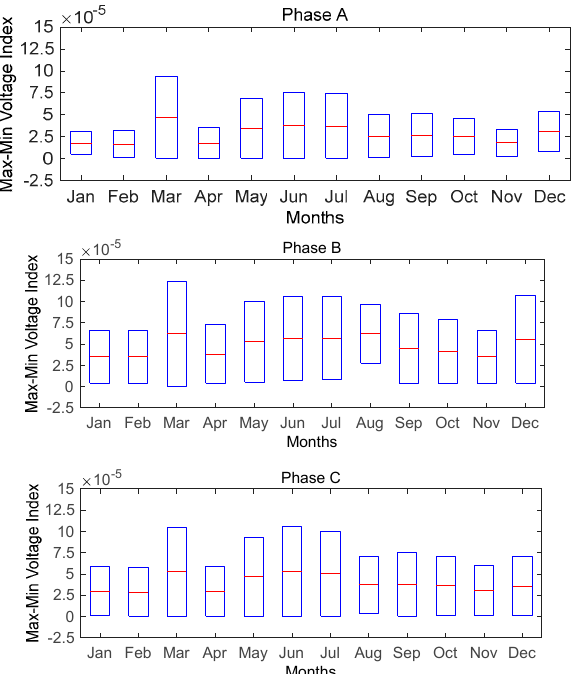
Figure 9. Computed voltage index at base load condition with low solar radiation profile.